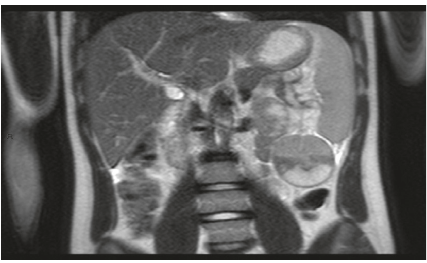
Figure 3: T2-weighted gadolinium-enhanced coronal view of MRI showing hemorrhage within the